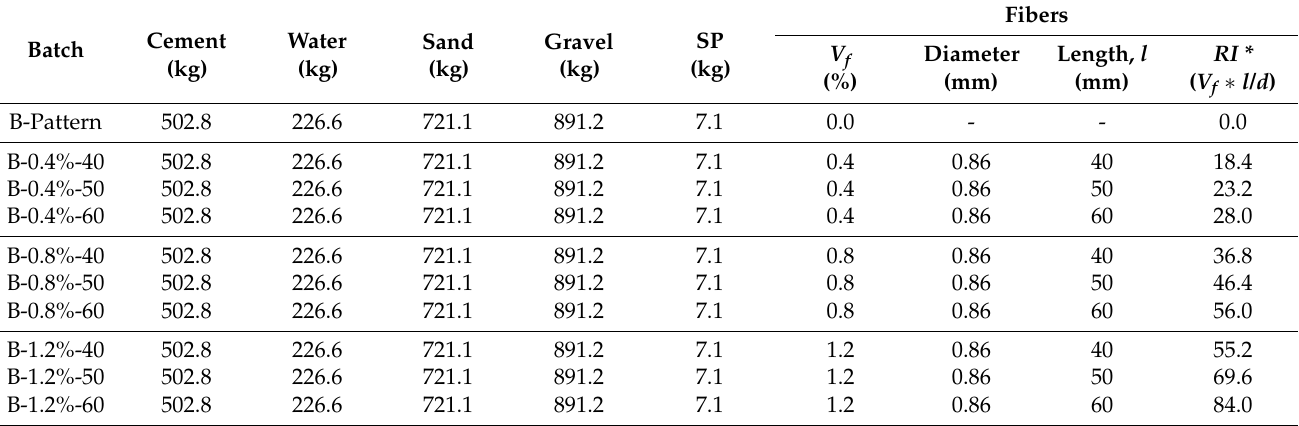
Table 1. Mixture design for a cubic meter of concrete f c = 40